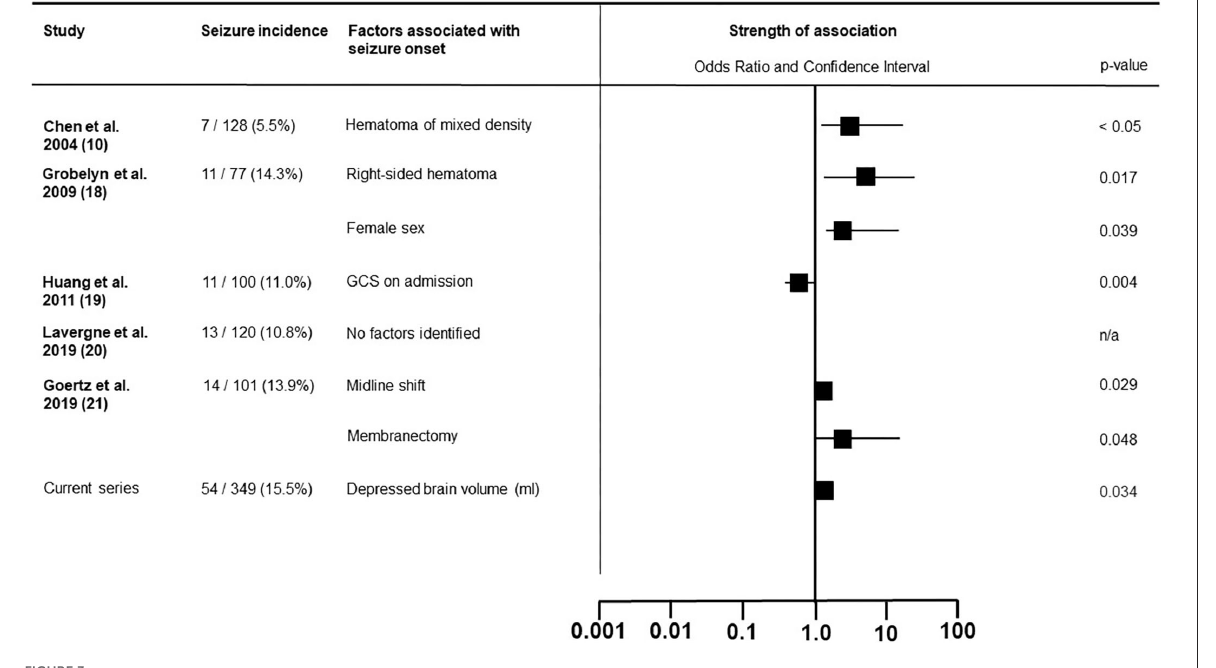
FIGURE3 Literature overview of the factors associated with postoperative epileptic seizure in patients surgically treated for chronic subdural